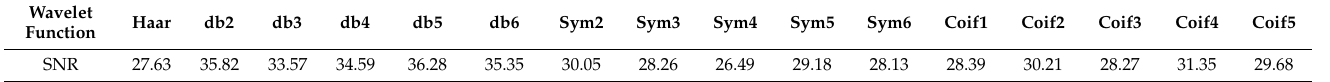
Table 3. The signal-to-noise ratio of passenger disembarking from the